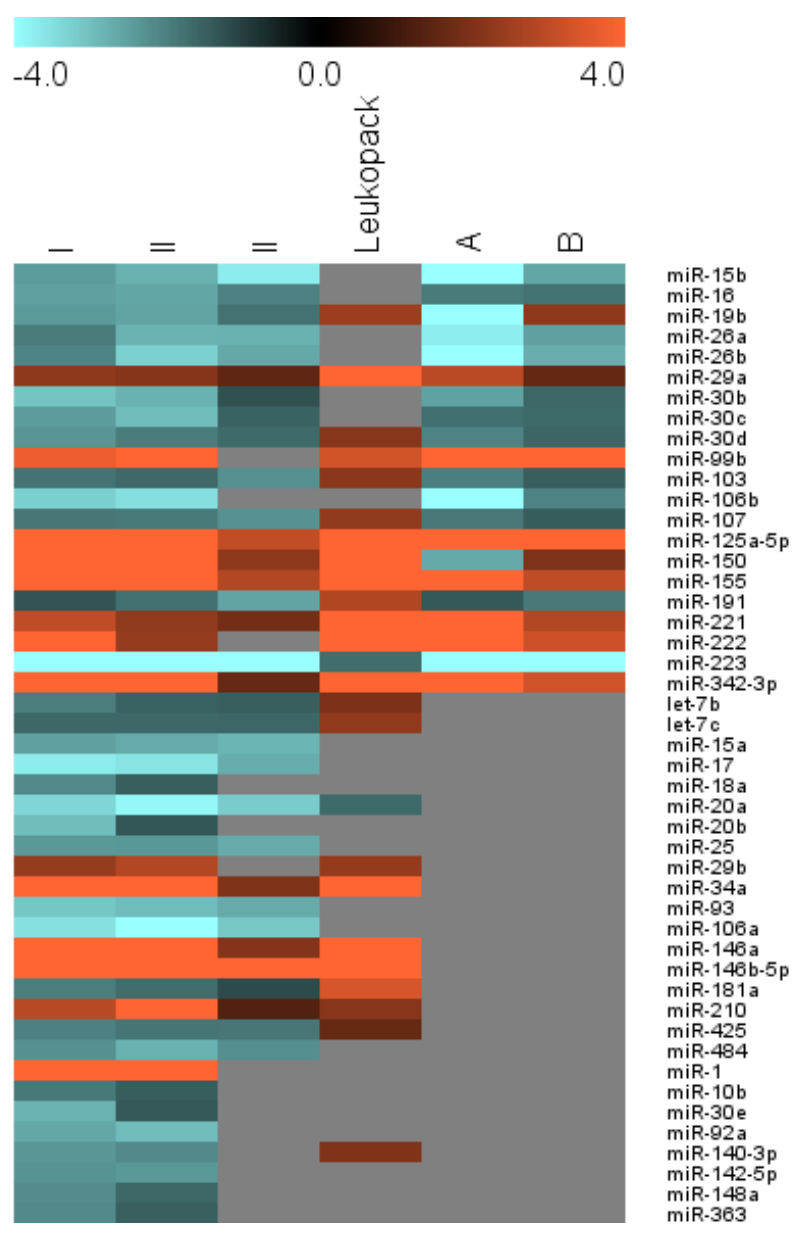
Figure 1. Graphic representation of fold changes for selected miRNAs, comparing monocytes with monocyte-derived macrophages. Positive values indicate enrichment in macrophages over monocytes. Fold changes were calculated for each miRNA from each of three donors: I, II, and III, using normalization by median centering for two dye-swap array experiments for each donor/sample with averaging of three triplicate measurements for each miRNA. Results of a leukopack experiment are also shown. ‘A’ and ‘B’ are provided for the sake of comparison: the results of hybridization array analysis performed and reported previously by Sung and Rice and calculated from data obtained from the Rice lab website [41]. Gray indicates that the corresponding miRNA was not detected or not differentially regulated in the respective arrays. See Table 2 for exact fold change calculations, statistics, and results of alternative analysis. MIAME-compliant raw and processed data from the triplicate fresh blood draws are available from GEO as GSE39905; leukopack data are available upon